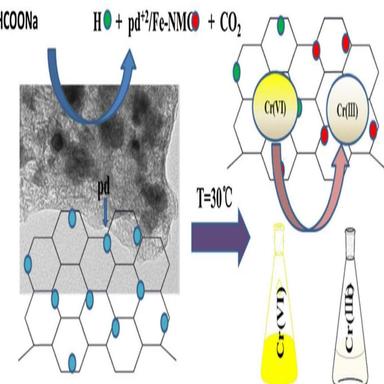
The proposed reaction scheme of Cr(VI) removed by Pd/Fe-NMC (,).